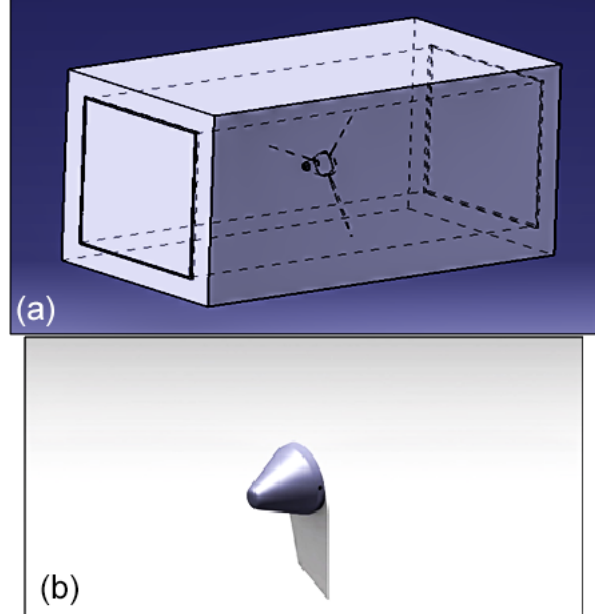
Figure 5. (a) 3-D model of the rotor. (b) Assembled blade and rotor in the wind